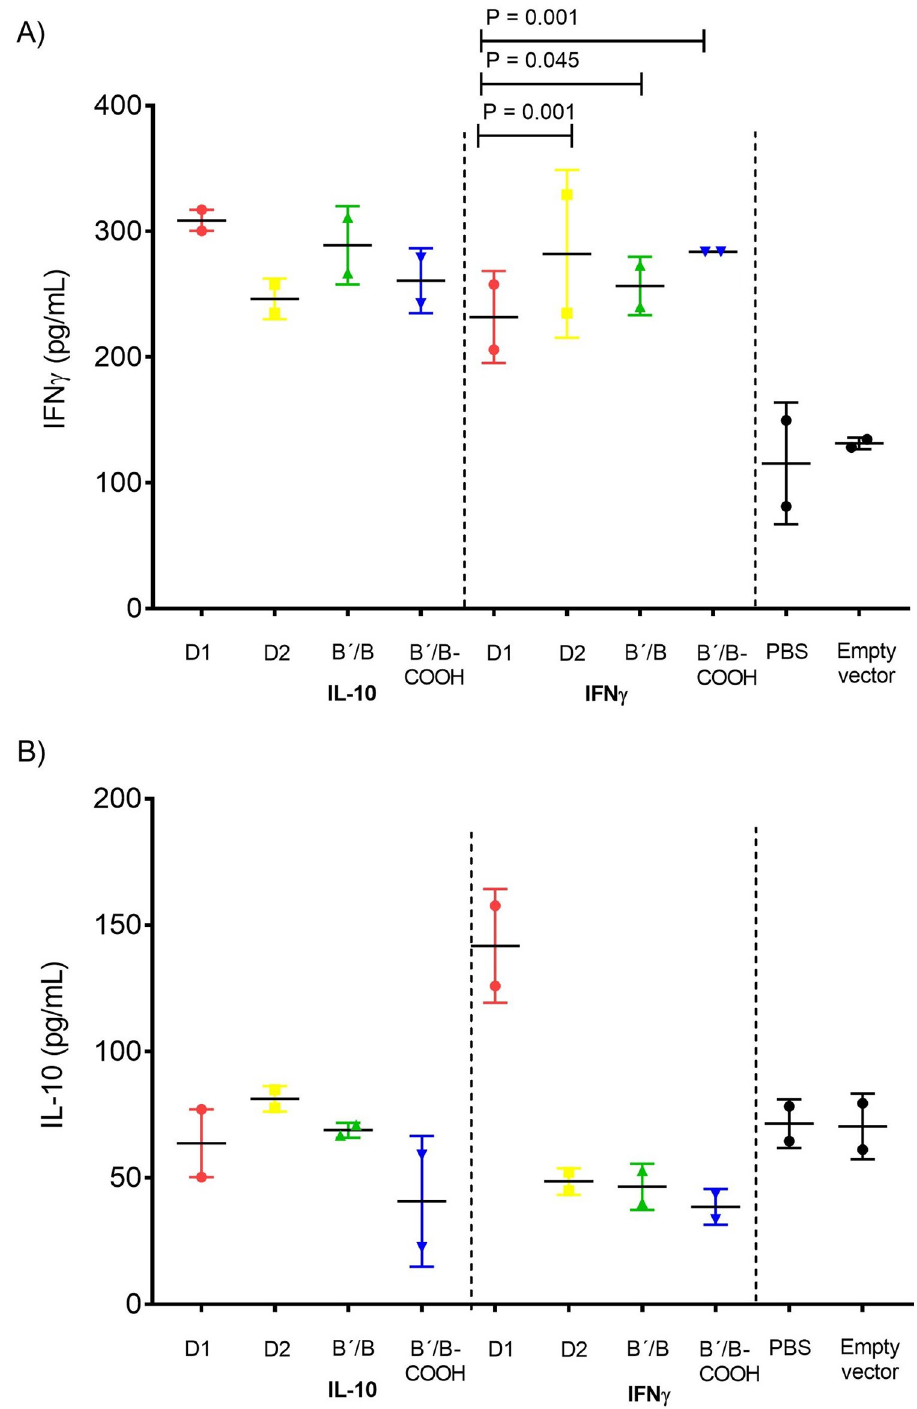
Fig 6. Cytokine levels in splenocyte supernatants. Panel A) IFN- γ levels in prophylactic co-vaccinated groups with D1 (83–119) , D2, B´B and B´B COOH along IFN- γ and IL-10, PBS and mock treatment. Panel B) IL-10 levels in prophylactic co-vaccinated groups with D1 (83–119) , D2, B´B and B´B COOH along IFN- γ and IL-10, PBS and mock treatment. Mann-Whitney test was used.